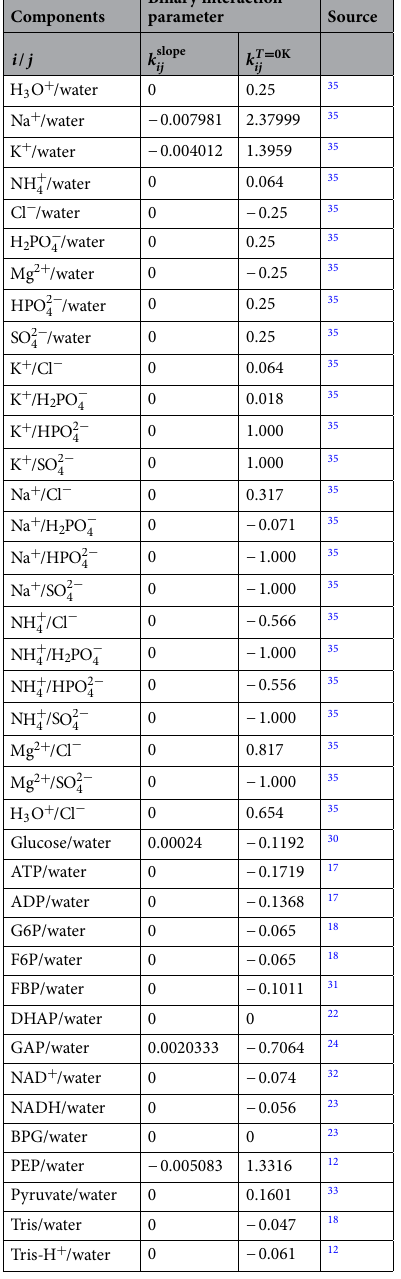
Table 3. Binary interaction parameters k ij between metabolites and water, between ions and water or among ions used in this